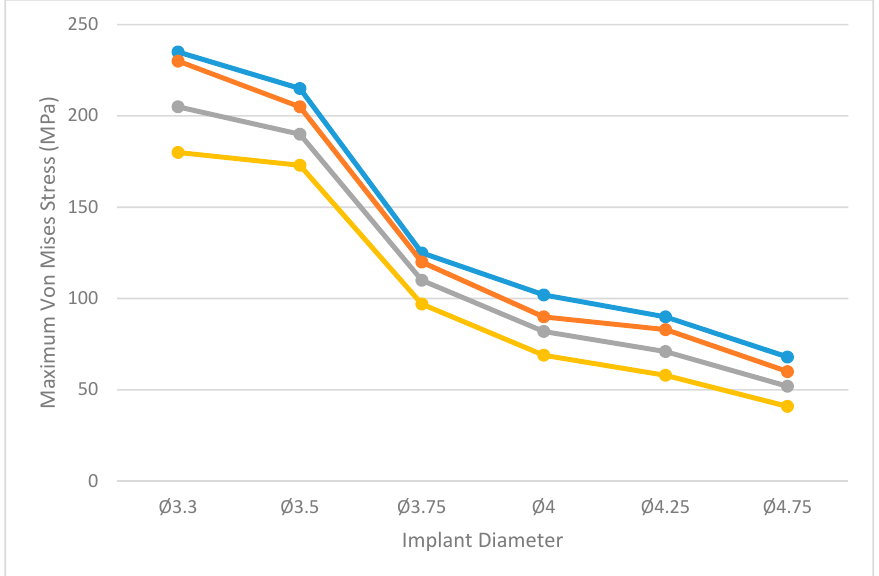
Figure 6. Maximum values of equivalent Von Mises stress (MPa) in bone tissue for each of the study scenarios under a 30 ◦ angled load of 200N. Bone type 0- I (yellow), bone type II (grey), bone type III (orange) and bone type IV